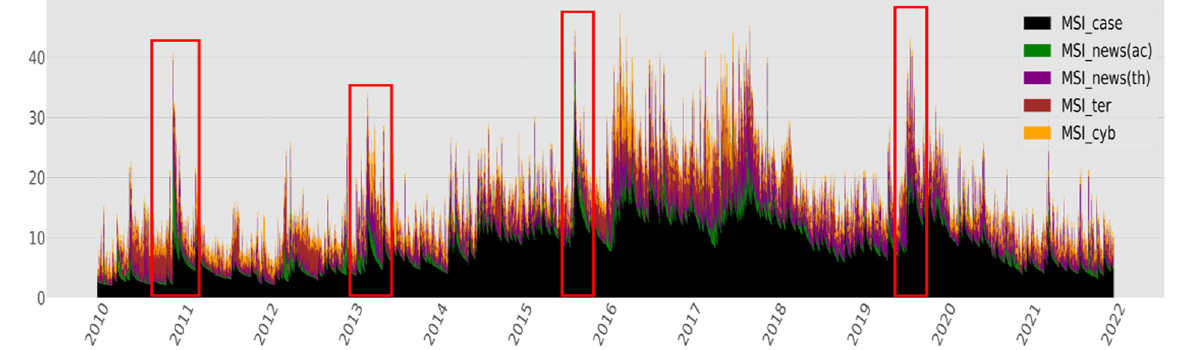
Figure 8. Military Security Index (‘10~’21).